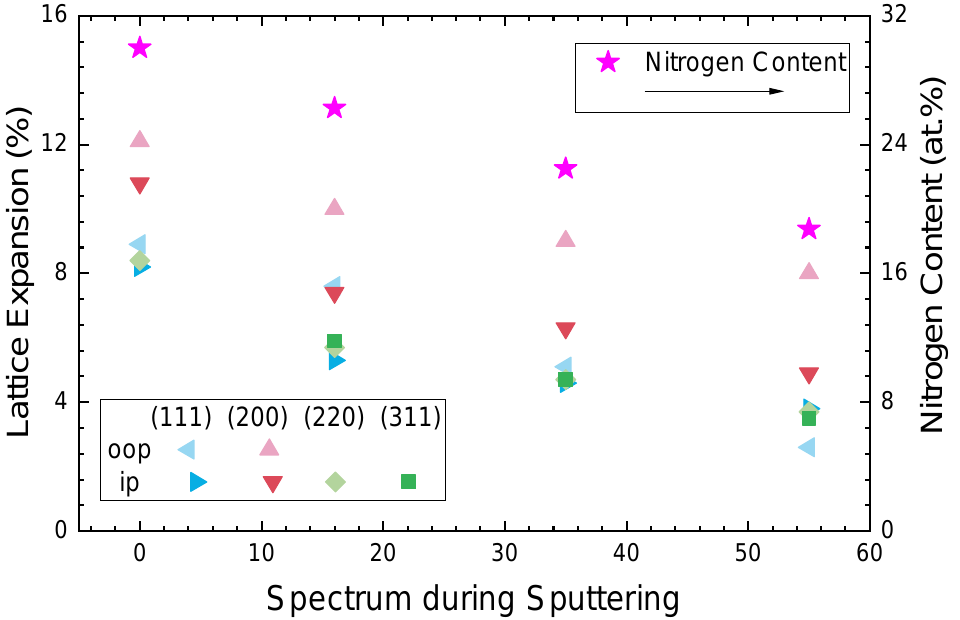
Figure 10. Comparison of lattice expansion as a function of grain orientation and XRD geometry for the sputter steps listed in Table 1. The respective measurement type (in-plane—ip vs. out-of-plane—oop) and the reflections are coded by color and symbol.